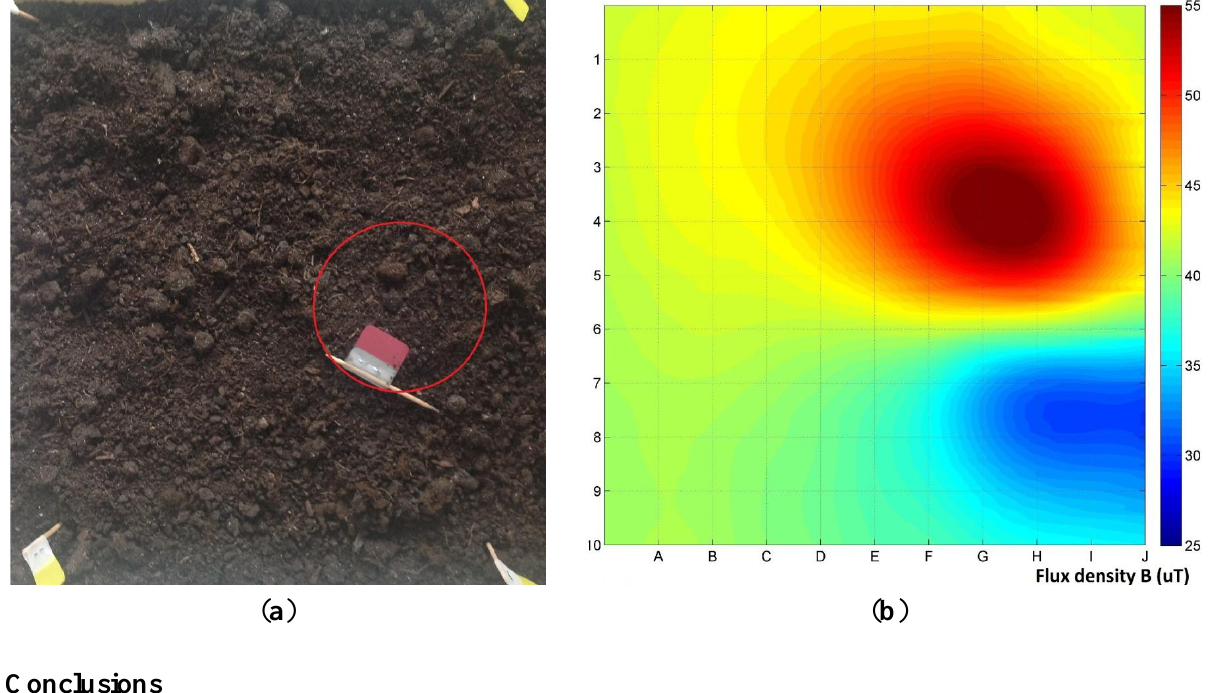
Figure 8. Application of the developed method of measurements to determine the location of a buried sample: (a) Comparison of the actual sample position (red circle); and (b) measurements